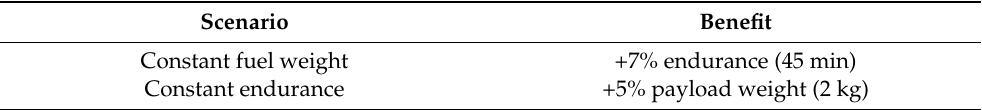
Table 5. Performance improvement of the HCUAV RX-1 due to riblets